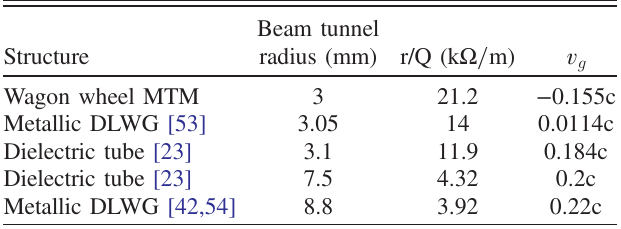
TABLE I. Recent and proposed X -band power extractor con- cepts, demonstrating the simultaneously high r/Q and group velocity of the metamaterial